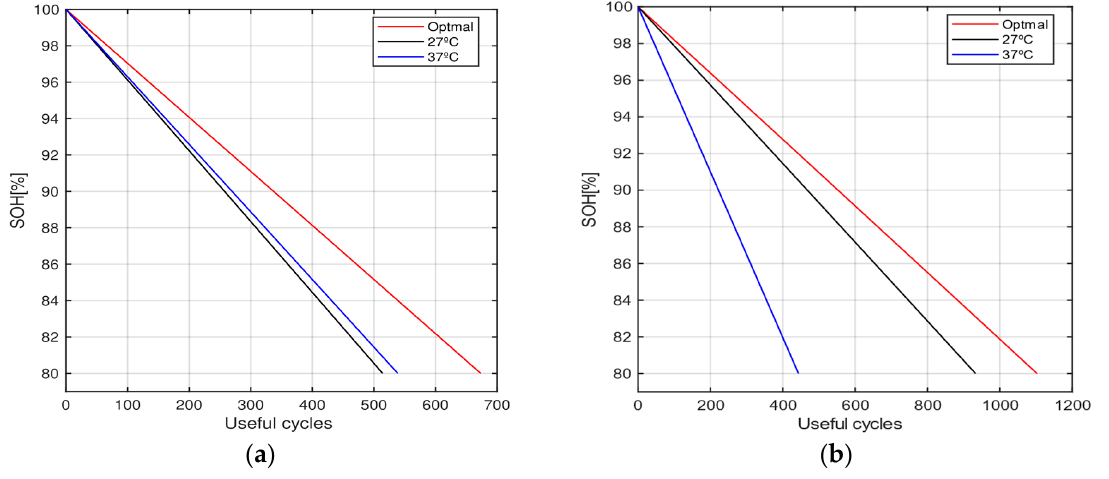
Figure 10. Simulation results for NMC cell at 1C ( a ) and 2C ( b ) discharge.